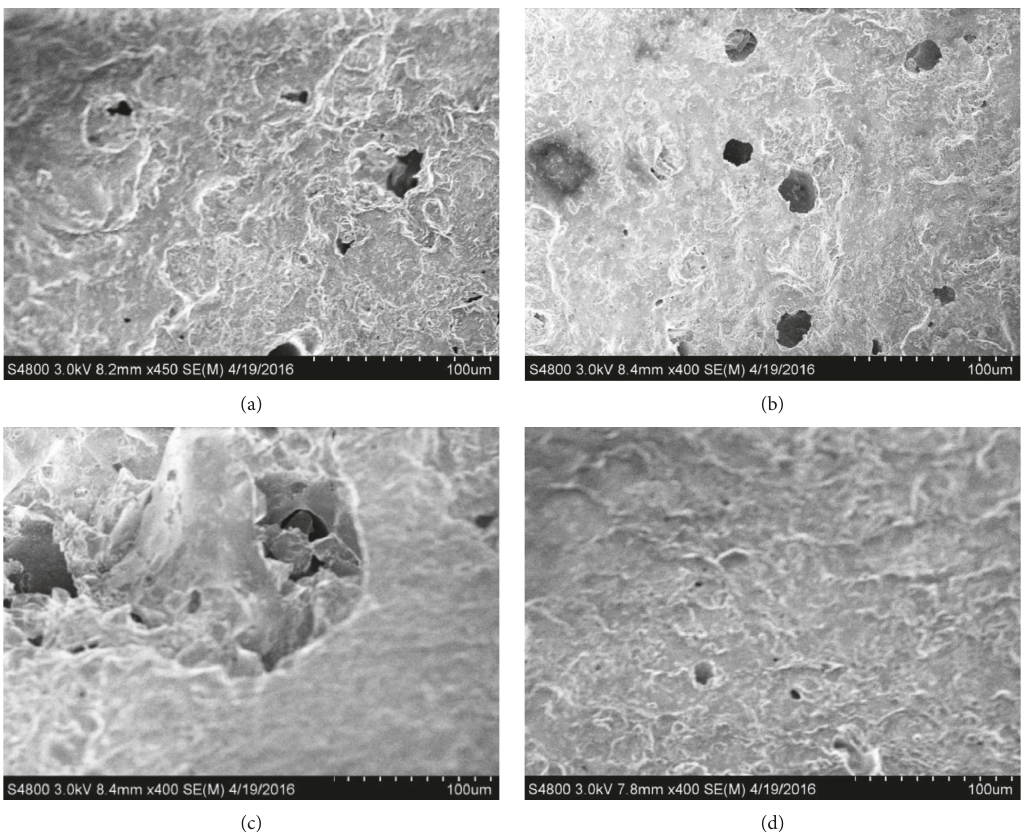
Figure 3: SEM images of ceramsite heated to different temperatures: (a) room temperature; (b) 400 ° C; (c) 800 ° C; (d) 1000 ° C.